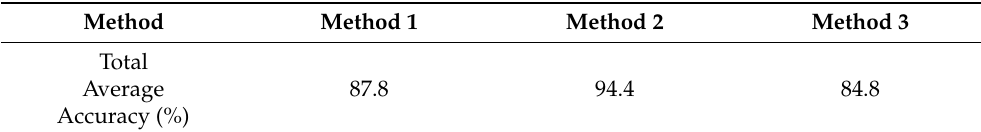
Table 12. Total Average